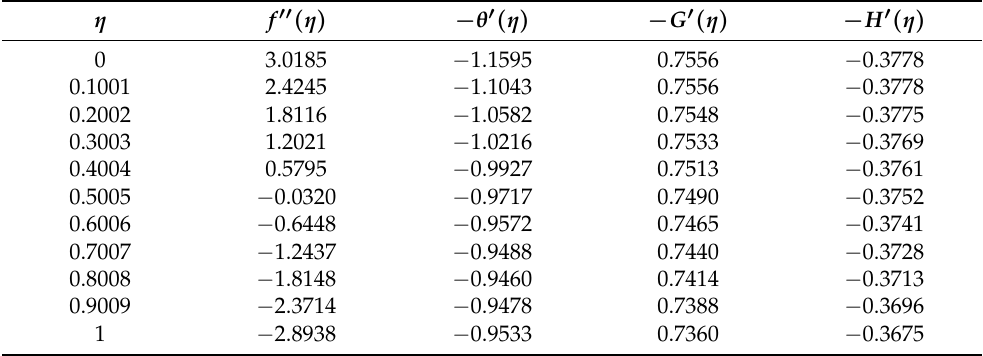
Table 2. Convergence of the homotopy solution for differing orders of calculation for f (cid:48)(cid:48) ( η ) , − θ (cid:48) ( η ) , − H (cid:48) ( η ) and − G (cid:48) ( η ) when S = − 0.5, Pr = R = M = Sc = K 1 = K 2 = Ha = 0.5, L = δ = 2, Q = 4.